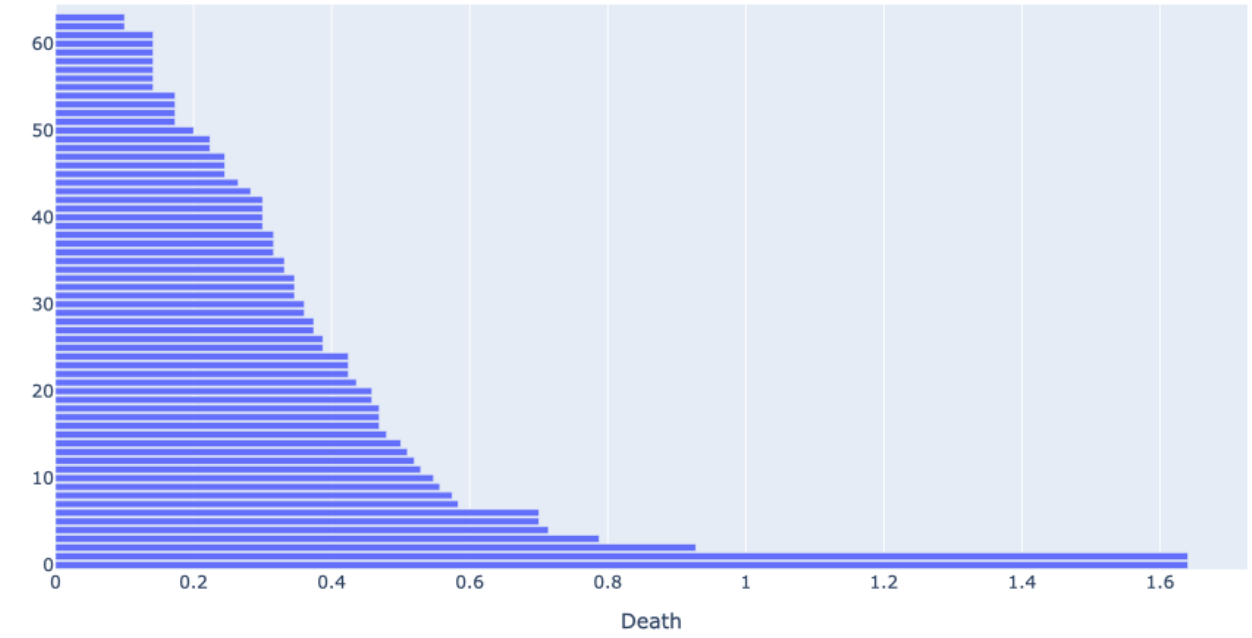
Figure 5. Bar Code obtained from running the developed 0-dimensional homology analysis on the IRIS dataset. The X-axis represents the death of each component. The Y-axis is the array index.